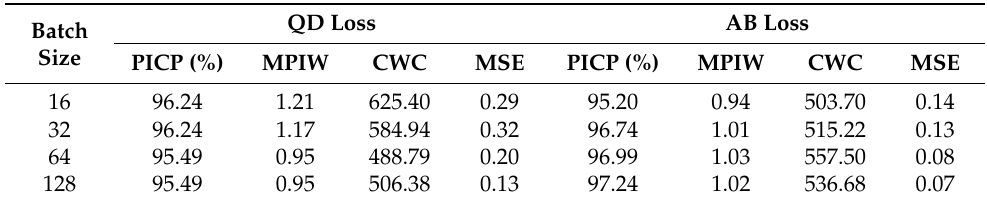
Table 3. Statistical characteristics of PICP, MPIW, CWC and MSE for the QD Loss and the AB loss with changing batch size.